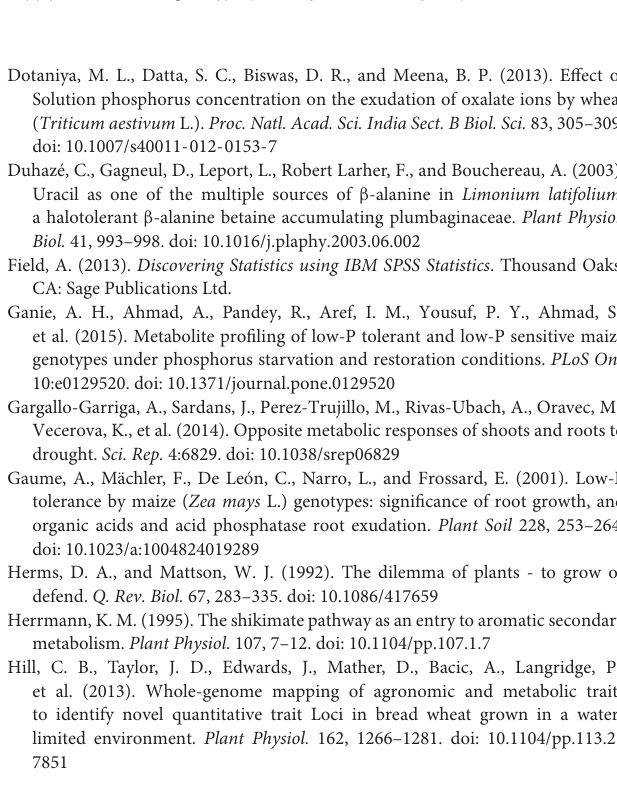
TABLE S4 | Fold-change in metabolite levels in roots of the P efficient RAC875 and P inefficient Wyalkatchem. Comparisons between low P supply and adequate P supply (low P/adequate P); and between RAC875 and Wyalkatchem (RAC875/Wyalkatchem) at each P supply. R, RAC875; W, Wyalkatchem; Low P,